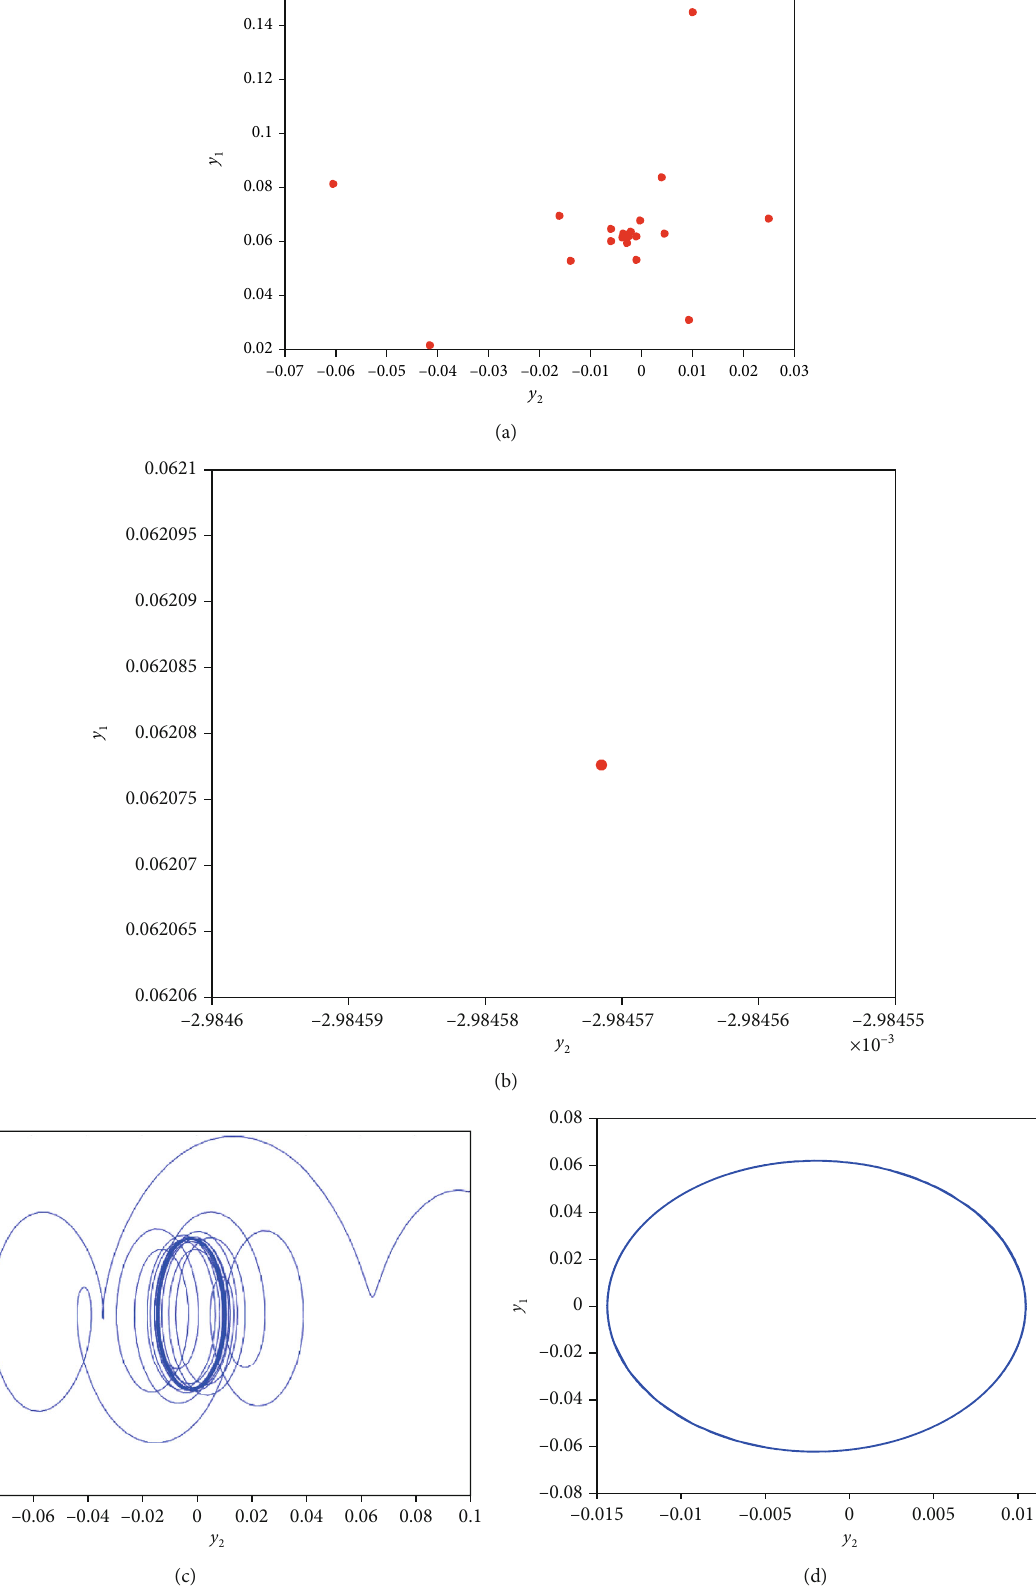
Figure 2: (a) Poincaré map; (b) Poincaré map (last 5000 points); (c) phase diagram; (d) phase diagram (last 10000